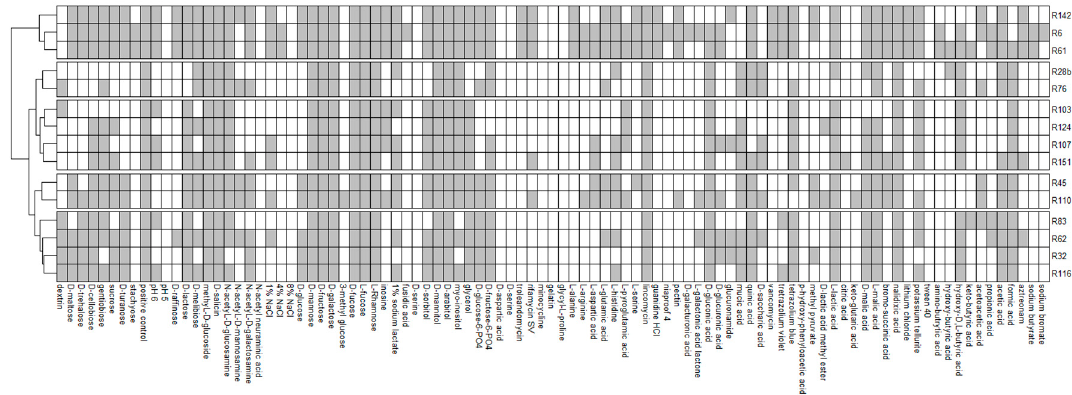
Figure 4. The heatmap showing results of the GENIII MicroPlate test (grey—growth in selected conditions, white—lack of growth).